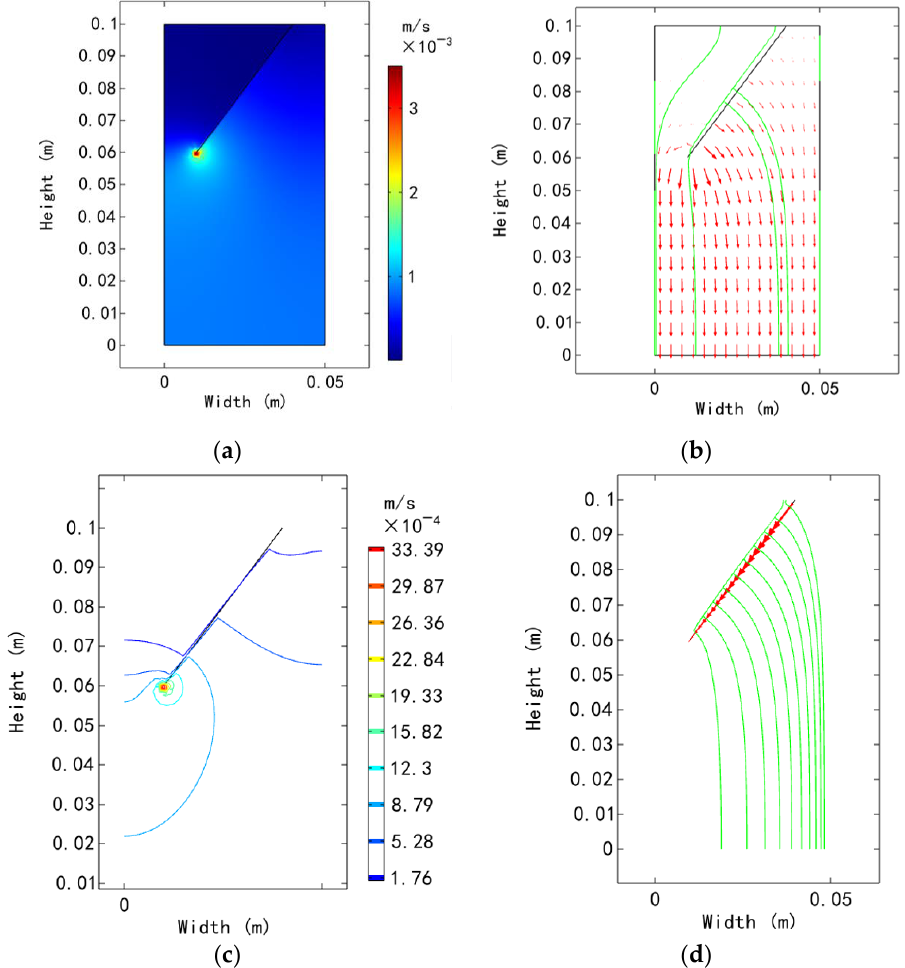
Figure 14. Distribution of the gas velocity in the upper fracture model. ( a ) Gas velocity in coal matrix; ( b ) gas velocity field in coal matrix; ( c ) gas velocity in upper fracture; ( d ) gas velocity filed in upper fracture.